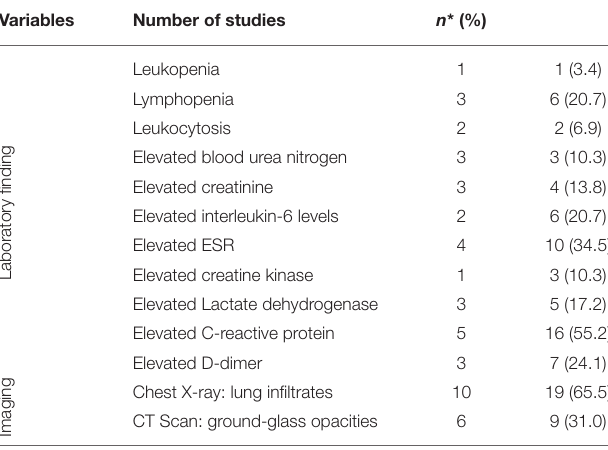
TABLE 6 | Laboratory and imaging findings of co-infected patients in case reports/case series studies among a total of 29 evaluated